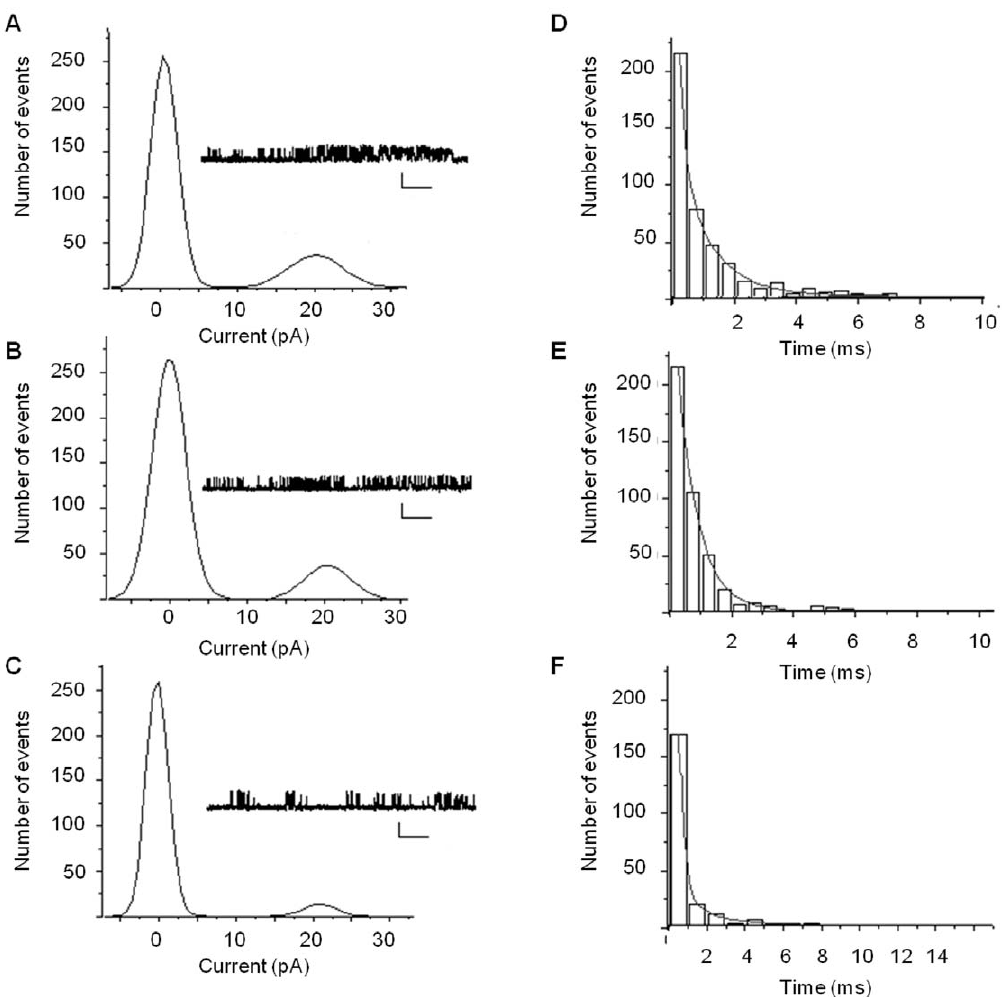
Figure 5. Ablation of MS cholinergic pathway alters the single channel properties of AMPA receptors. Sample traces of single channel recordings and respective current amplitude histograms for (A) non-infused, (B) saline infused, and (C) 192-saporin infused rats (Calibration: each 3 pA, 200 ms). Dwell open time histograms of (D) non-infused, (E) saline infused, and (F) 192-saporin infused rats were fitted by two exponential fittings. The AMPA elicited currents were completely blocked by the addition of CNQX (data not shown).